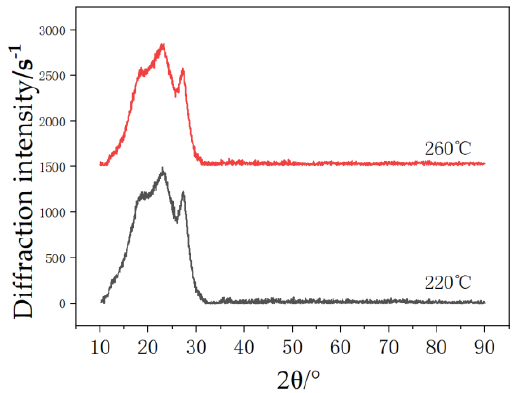
Figure 11. XRD diagrams of aramid insulating paper.